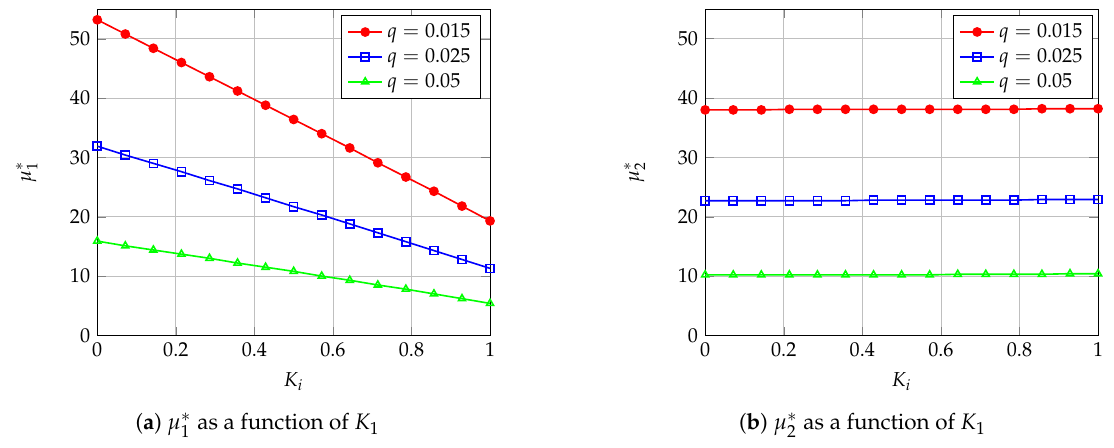
Figure 6. MNOs network capacity as a function of K 1 with K 2 = 0.45.